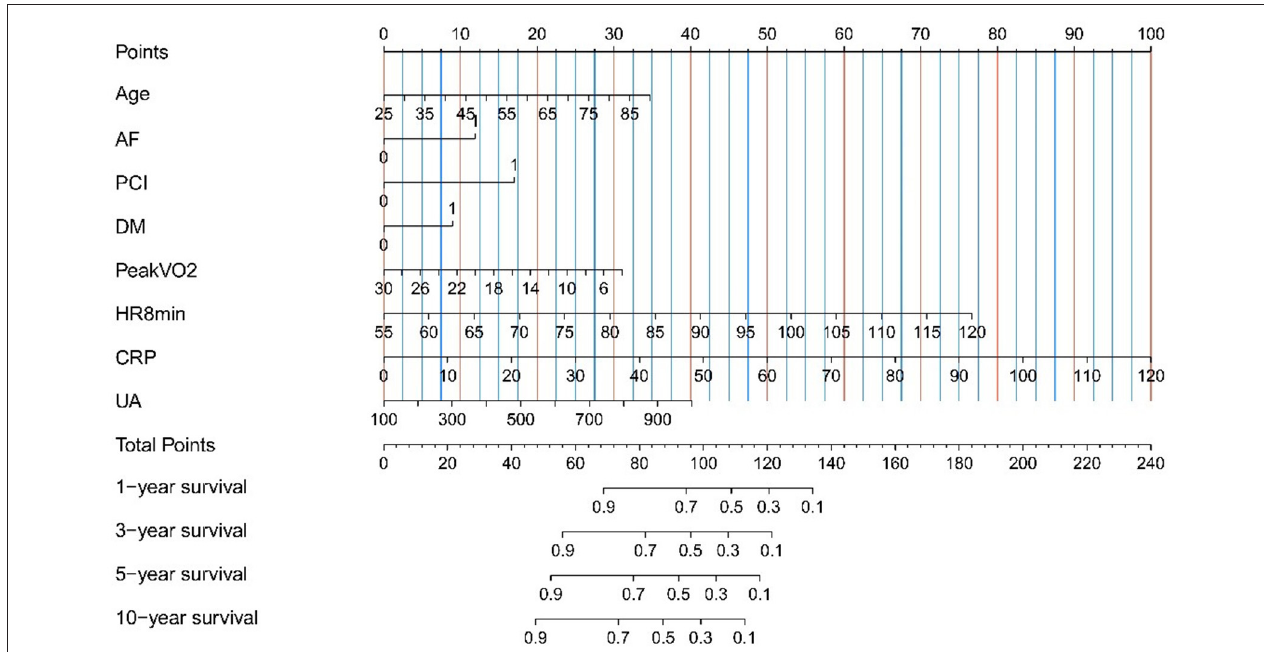
FIGURE 2 | Nomogram for the prediction of mortality and hospitalization in Chinese heart failure patients. Instructions for use of nomogram: draw a vertical line, and then add up the points corresponding to each feature, and then draw the vertical line according to the total points until it intersects each survival axis to determine the survival probability of 1, 3, 5, and 10 years. For binary variables, 0 = no, 1 = yes. AF, atrial fibrillation; CRP, c-reactive protein; DM, diabetes mellitus; HR8min, heart rate at the 8th minute after the cardiopulmonary exercise peaked; PCI, percutaneous coronary intervention; Peak VO 2 , peak oxygen uptake; UA, uric